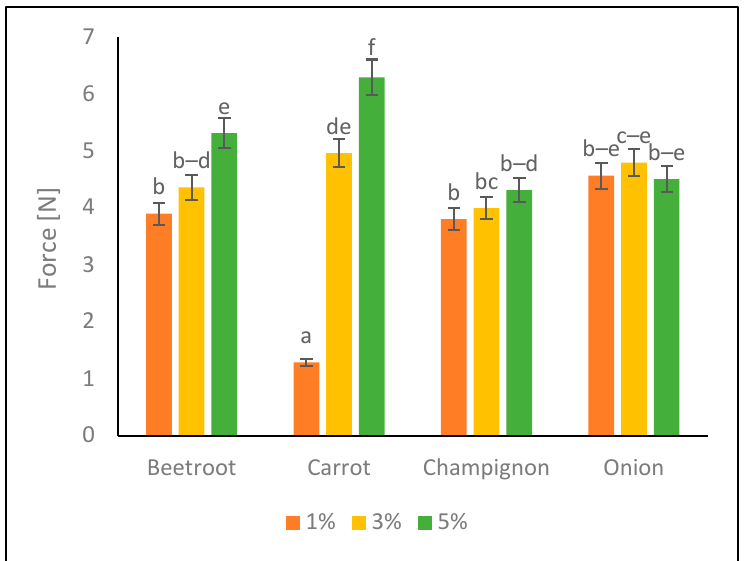
Figure 2. Effect of different amounts of dried vegetable powders on back extrusion values of fat-free dairy desserts. Letters (a–f) indicate significant differences at p < 0.05 (Tukey’s HSD test).